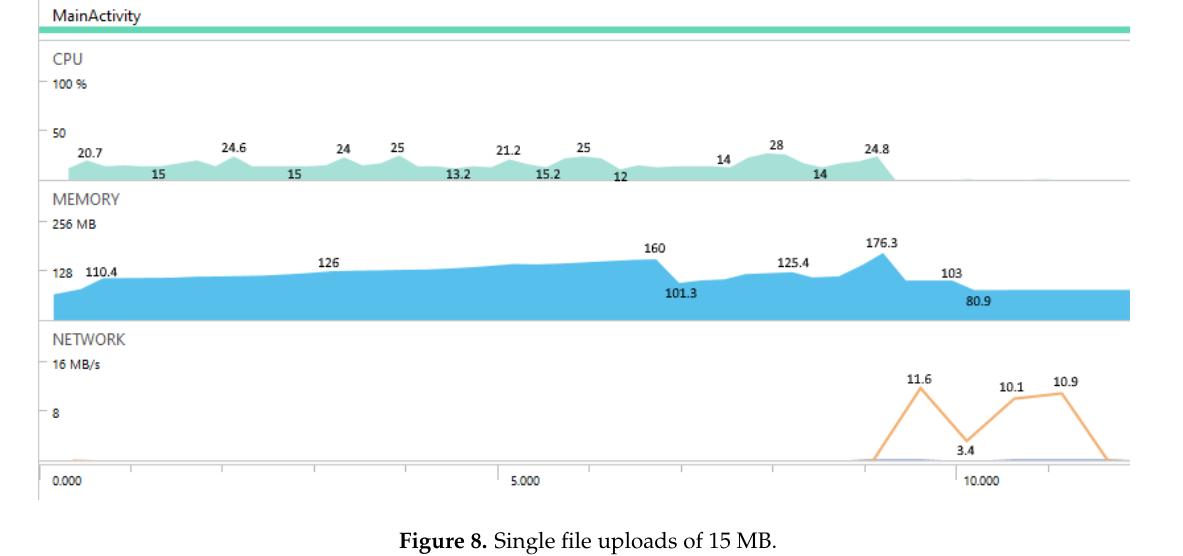
Figure 7. Single file uploads of 7.5 MB.